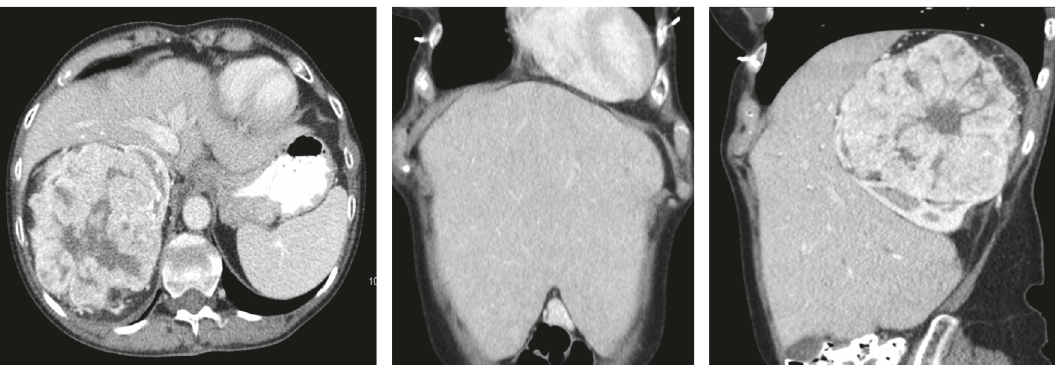
Figure 1: Abdominopelvic CT with IV contrast demonstrates a 14 cm enhancing mass in the right kidney. (a) Axial image shows there was significant enhancement of the solid components of the tumor with finger-like extensions of absent enhancement consistent with necrosis or inflammation. (b) Coronal image demonstrates the enlarged liver that filled all four abdominal quadrants. (c) In sagittal view, the liver is seen to be anteriorly displaced by the large renal mass and to extend down to the right iliac crest.